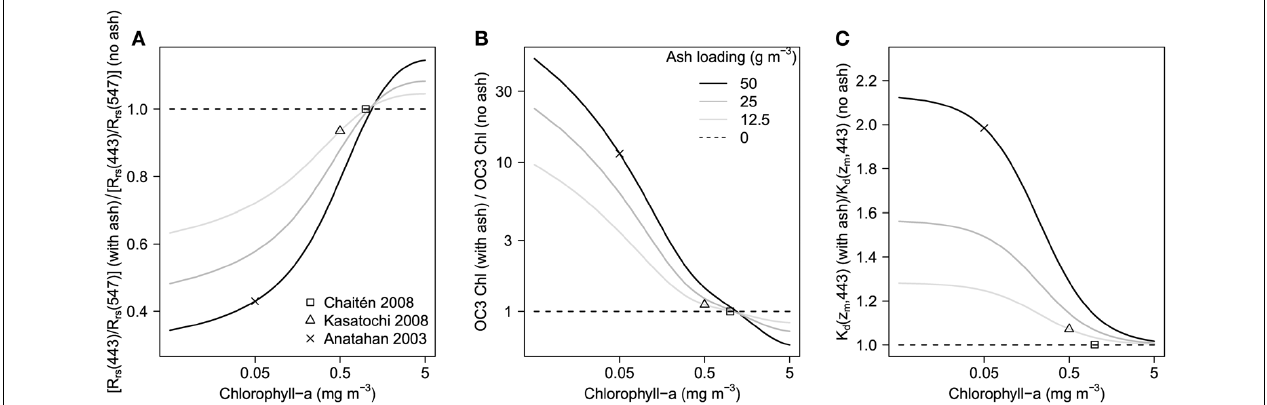
FIGURE 4 | Relative influence of suspended Chaitén ash on (A) the satellite-retrieved blue:green R rs ratio, (B) resultant OC3-derived chlorophyll-a concentrations (using R r = R rs ( 443 )/ R rs (547)), and (C) K d ( z m ,λ) . Ash-biased values are normalized to the no-ash case for three ash loadings at a range of seawater chlorophyll-a concentrations. The influences of the expected ash loading for three eruptions that have been investigated for phytoplankton response in this study are highlighted (note that apart from Chaitén 2008, the applicability of these optical properties to the other ash types are uncertain). “Actual” seawater chlorophyll-a has been estimated from the pre-eruption satellite-retrieved concentrations. The estimated ash loading has a variable sensitivity to the relative level of bias depending on the